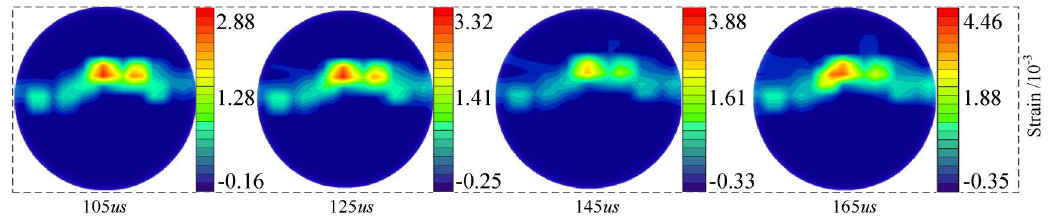
Figure 9. Dry coal sample maximum principal strain cloud